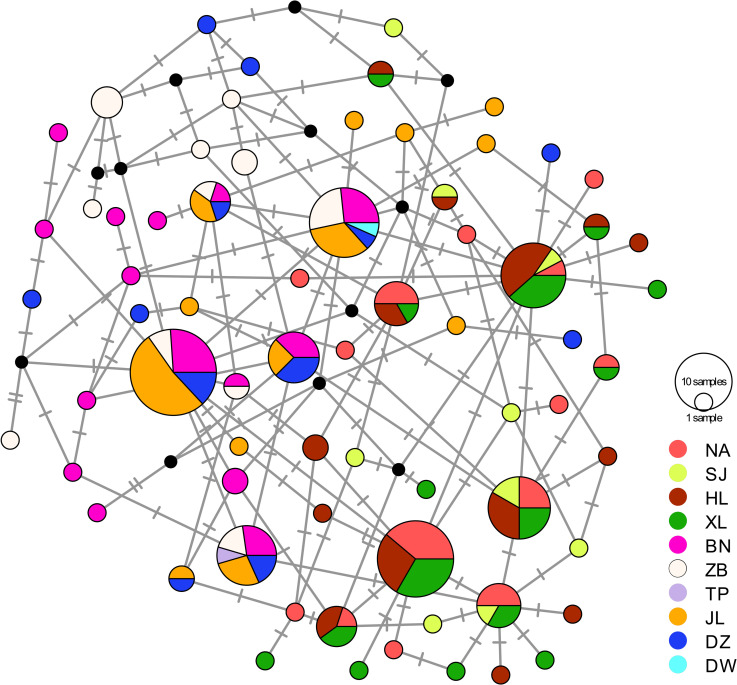
Median-joining network of 191 concatenated mtDNA sequences (1074 bps) of Rhinogobius gigas.Colors represent different sampling basins; size of pie charts is proportional to the number of individuals; dashes and black circles are haplotypes not collected in this study; basin names of codes are given in Table 1.